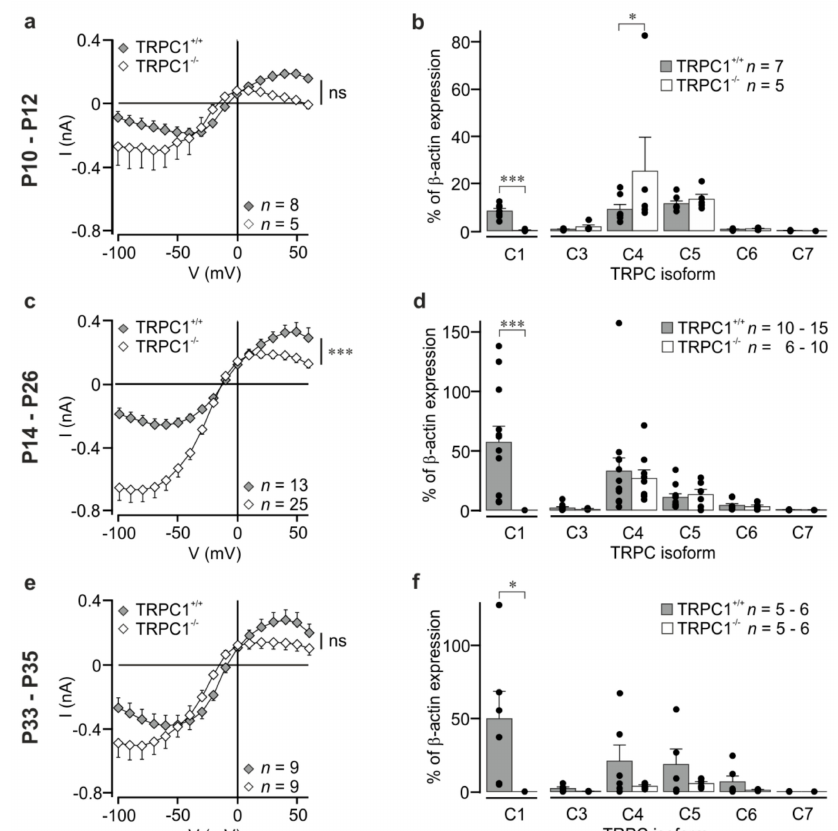
Figure 2. Mean mGluR I-activated currents and TRPC isoform expression at three di ff erent stages of postnatal development. ( a , c , e ) Mean DHPG-activated current-voltage relationships in CA1 neurons from TRPC1 +/+ (filled symbols) and TRPC1 − / − mice (open symbols) in the age ranges P10–P12, P14–P26, and P33–P35, respectively. Values are means ± SEM. The asterisks at the side indicate the result of a two-way ANOVA. The data in (c) are the same data as those shown in Figure 1c,d. All points in (a,c,e) were extracted from ramp data at 10 mV intervals. ( b , d , f ) TRPC isoform expression determined by qRT-PCR in the hippocampi of TRPC1 +/+ (filled columns) and TRPC1 − / − mice (open columns) in the age ranges P10–P12, P14–P26, and P33–P35, respectively. The dots show the individual values, and the number of experiments per genotype is shown in each panel. Asterisks indicate: *** p < 0.001; * p < 0.05, and ns not significant (Student’s t test for TRPC1; two-way ANOVA with Bonferroni post-hoc test for